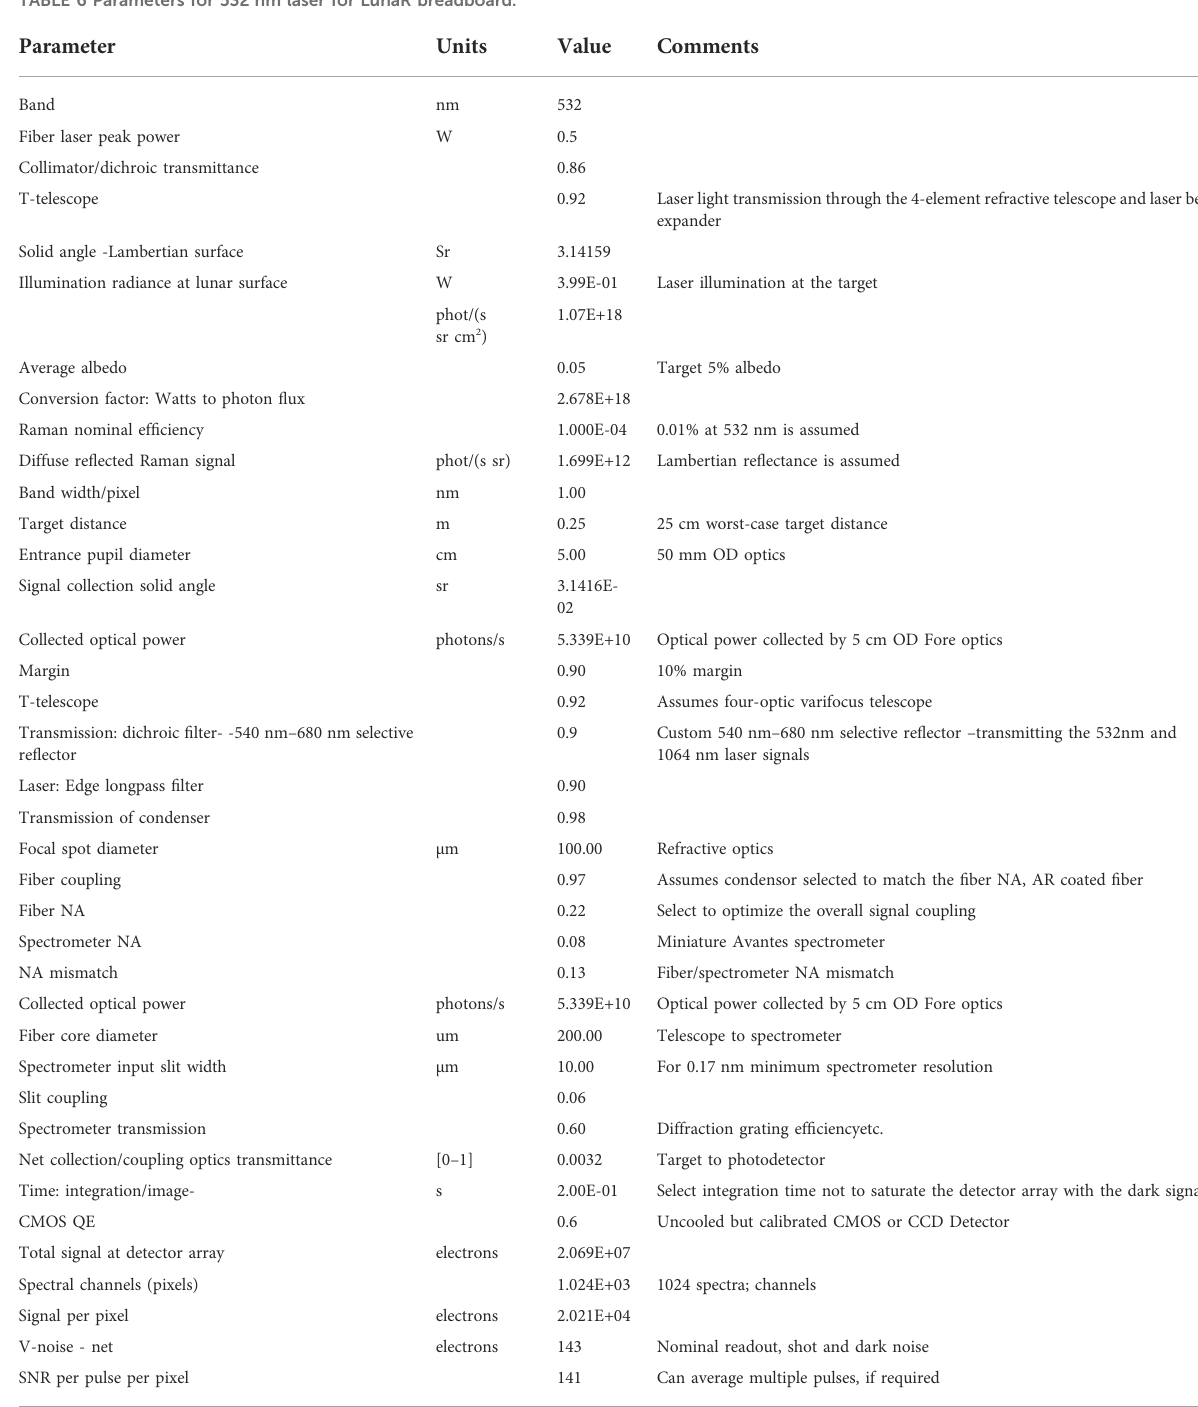
TABLE 6 Parameters for 532 nm laser for LunaR